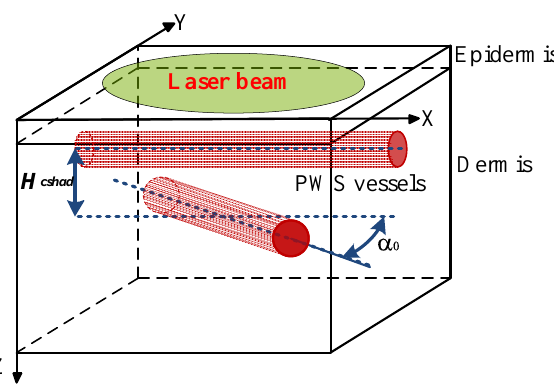
9 of 14 Figure 11. Line graph of energy deposition vs. depth at the beam center for simulations of skin with parallel blood vessels with different H shad values at θ shad = 90°. 3.2. Cross-Bridge Blood Vessels